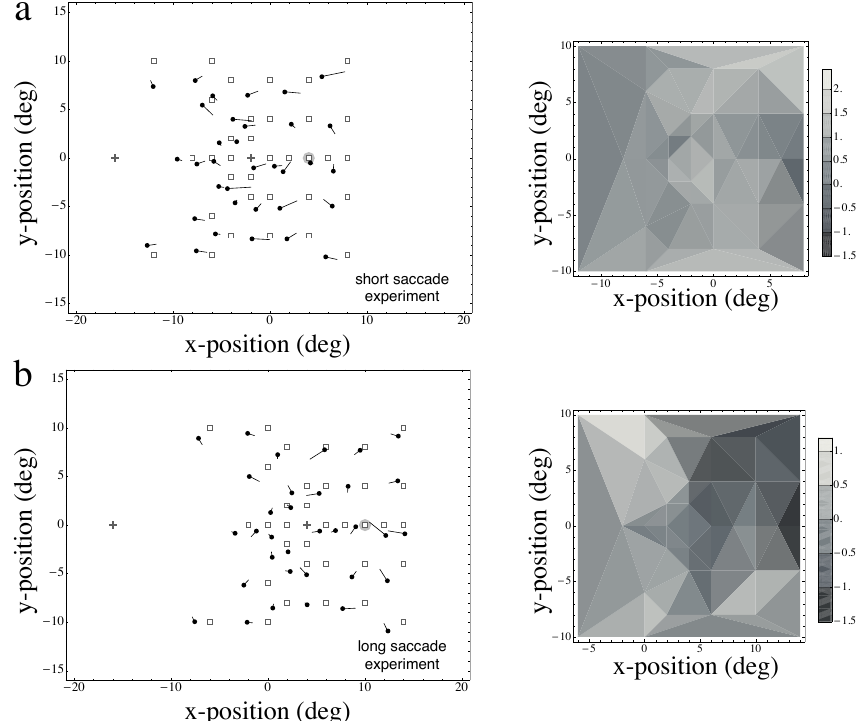
a: Fixation localization judgements in the short saccade experiment. b: Fixation localization judgements in the long saccade experiment. Both figures are with their corresponding heat maps. Filled circles indicate the mean of fixation localization judgements in the pre-adaptation phase and end of the line the mean of fixation localization judgements in the post-adaptation